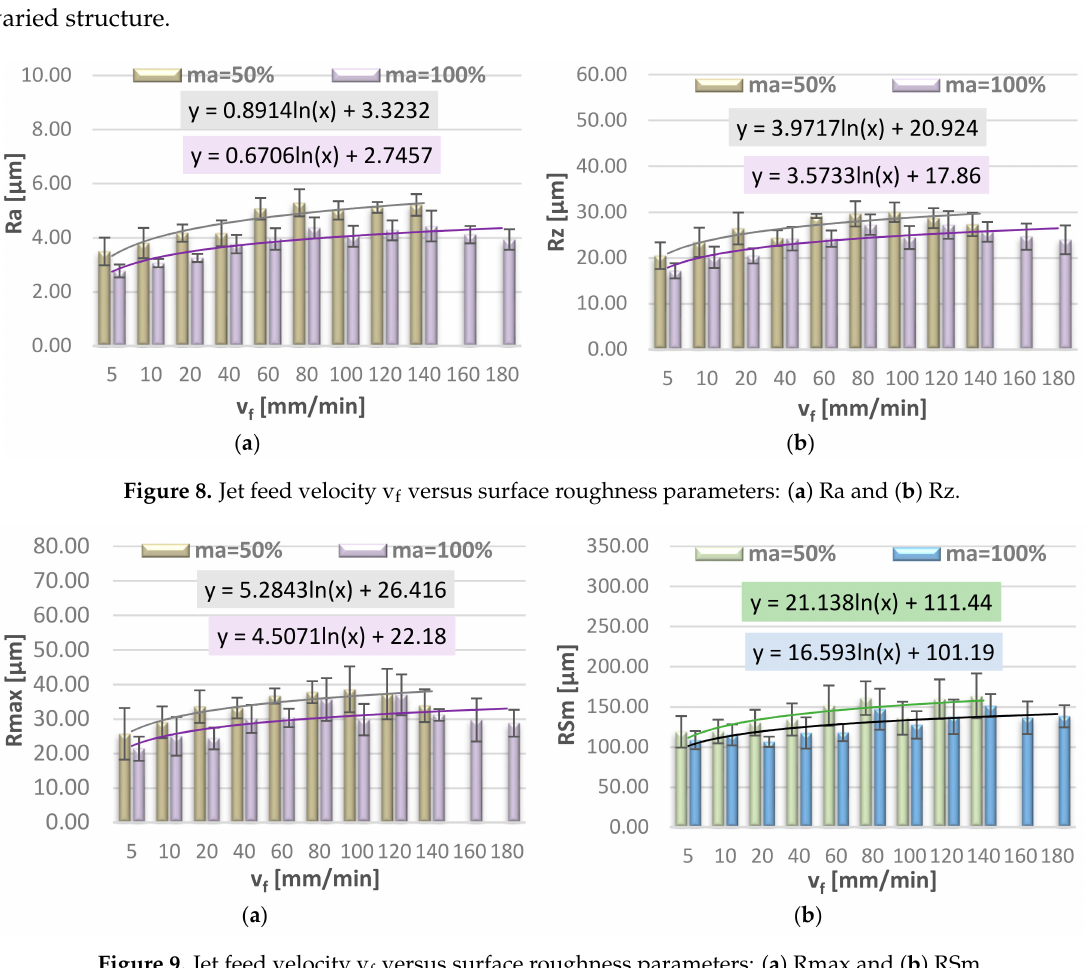
Figure 9. Jet feed velocity v f versus surface roughness parameters: ( a ) Rmax and ( b ) RSm.